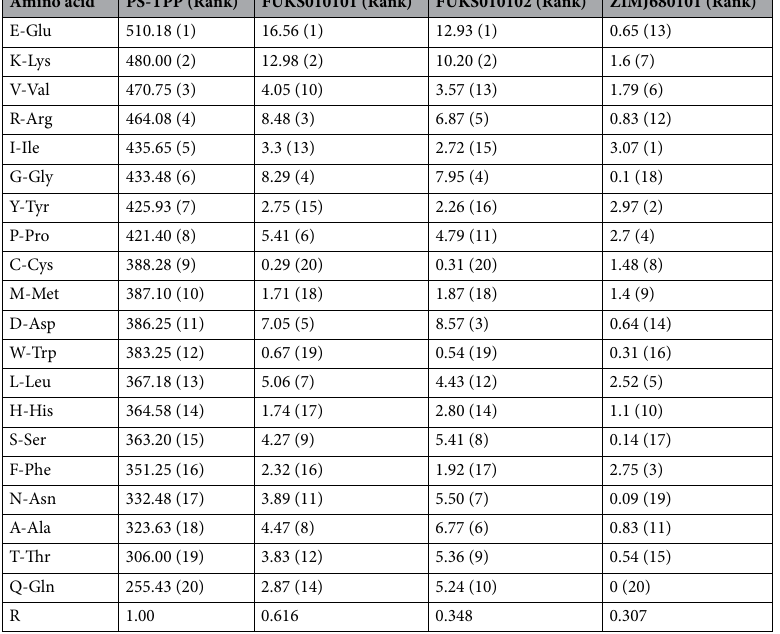
Table 8. Summary of four important physicochemical properties as determined by